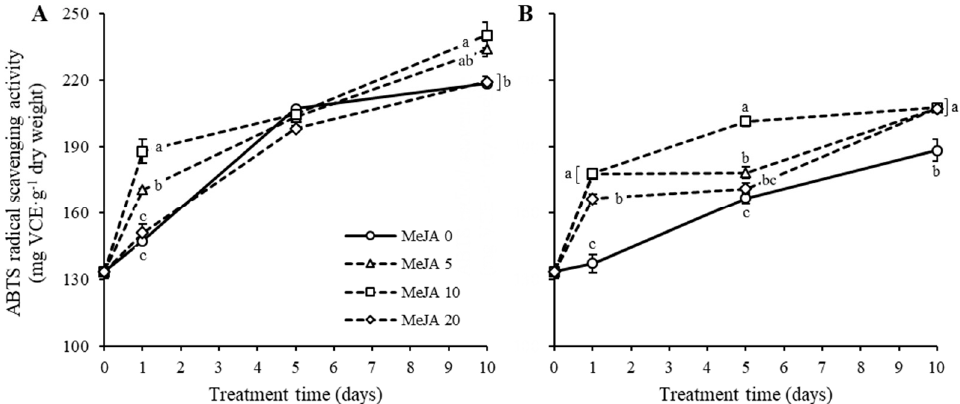
Figure 5. ABTS radical scavenging activity of marigold petals treated to series of MeJA concentra- tion either without UV-B ( A ) or with 1 W ∙ m − 2 ∙ s − 1 UV-B ( B ) for 10 days. Antioxidant activities were expressed as mg VCE ∙ g − 1 dry weight. VCE indicates vitamin C equivalents. Error bars on each graph indicates standard errors of triplicate samples. Statistical significance within treatment day was performed with Tukey’s studentized test (HSD) at p < 0.05.